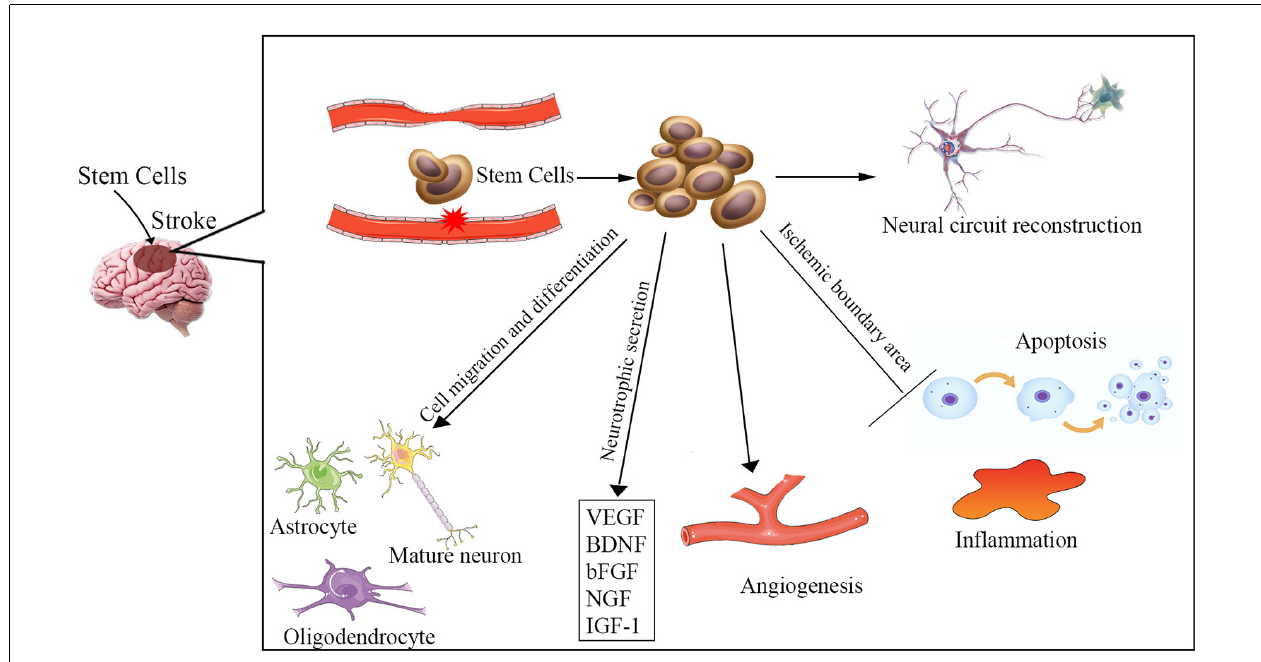
FIGURE 1 | Overview of the potential mechanisms of stem cell therapy for ischemic stroke. Neuronal injury, increased apoptosis, inflammatory reaction, and vascular remodeling are involved in the pathophysiology of ischemic stroke. The underlying mechanisms of stem cell therapy for ischemic stroke may be to reverse these processes, including cell migration and differentiation into various cells to replace damaged neurons, neurotrophic secretion, apoptosis and inflammation inhibition, angiogenesis, and enhancement of neural circuit reconstruction. VEGF, vascular endothelial growth factor; BDNF, brain-derived neurotrophic factor; bFGF, basic fibroblast growth factor; NGF, nerve growth factor; IGF-1, insulin-like growth factor